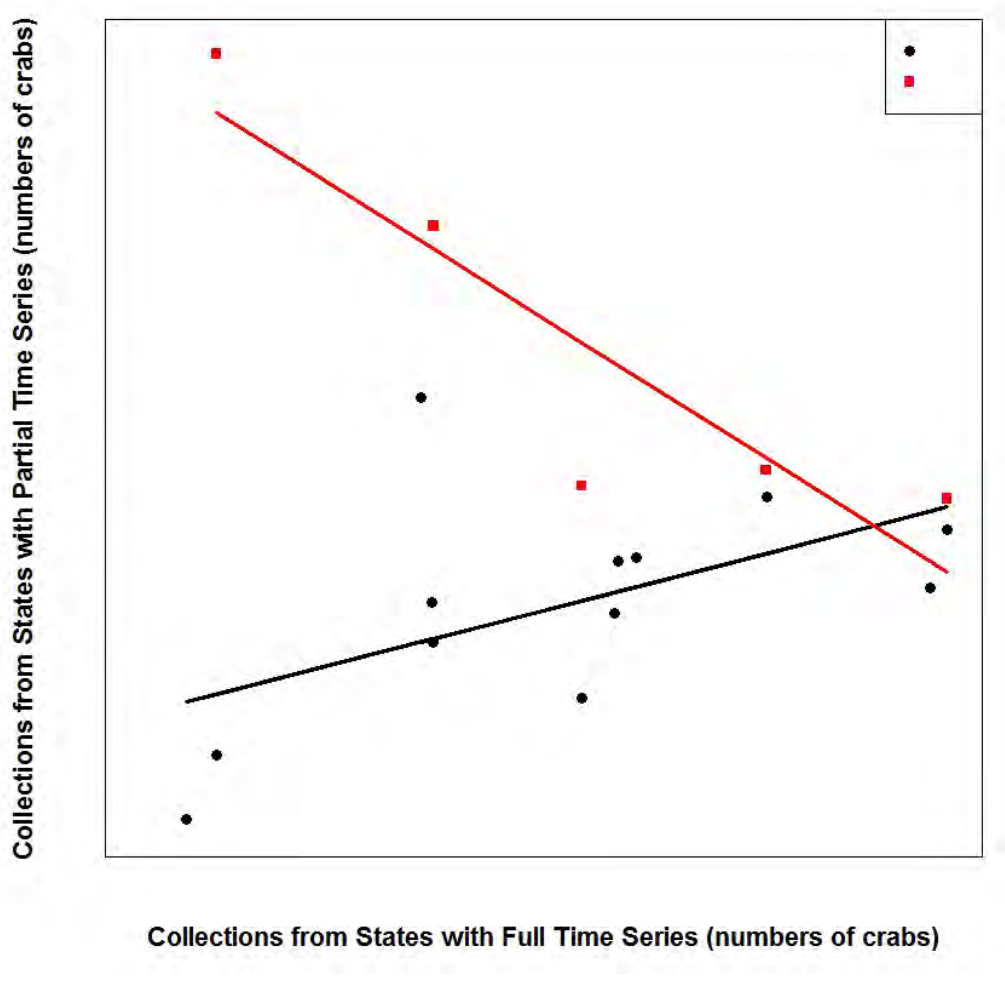
Figure 10. Linear regressions of biomedical collections of horseshoe crabs from states with partial and full time series from 1999-2017. Axis values and state names have been removed due to CONFIDENTIAL